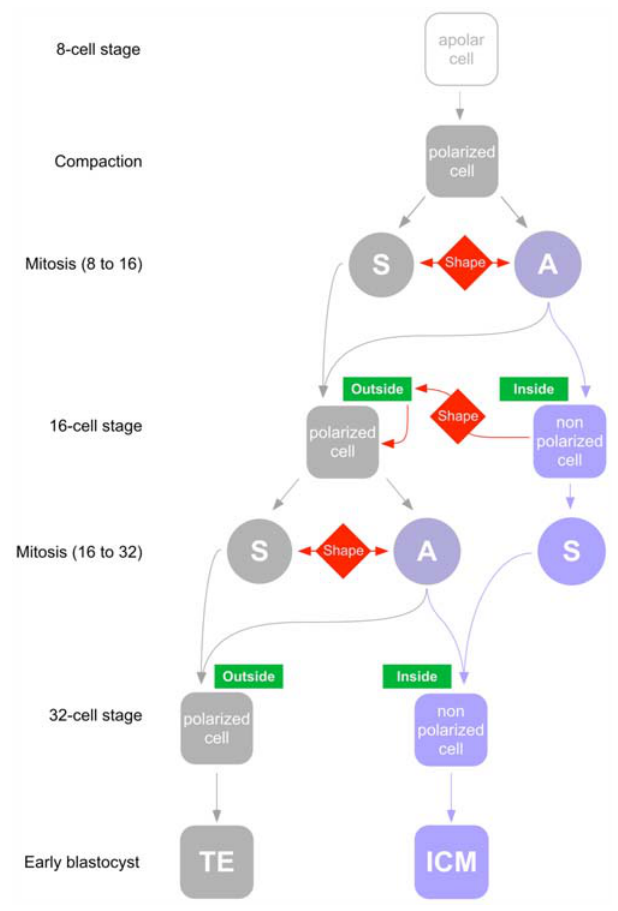
Figure 8. Lineage allocation during mouse preimplantation development. Until the early 8-cell stage, blastomeres are apolar. At compaction, blastomeres polarize and flatten upon each other. During the following mitosis, they divide either symmetrically (S) or asymmet- rically (A). Although spindle orientation is random, the ratio between symmetrical and asymmetrical cell divisions can be modulated by cell shape constraints. After division, non-polar cells are localized inside the embryo (since they are derived from the basal part of 8-cell blastomeres) while polar cells are located at the periphery. At the 16- cell stage, before the formation of tight junctions (or in their absence) cell shape constraints can force inside cells to move at the periphery (red arrow). These cells will polarize because of the asymmetry